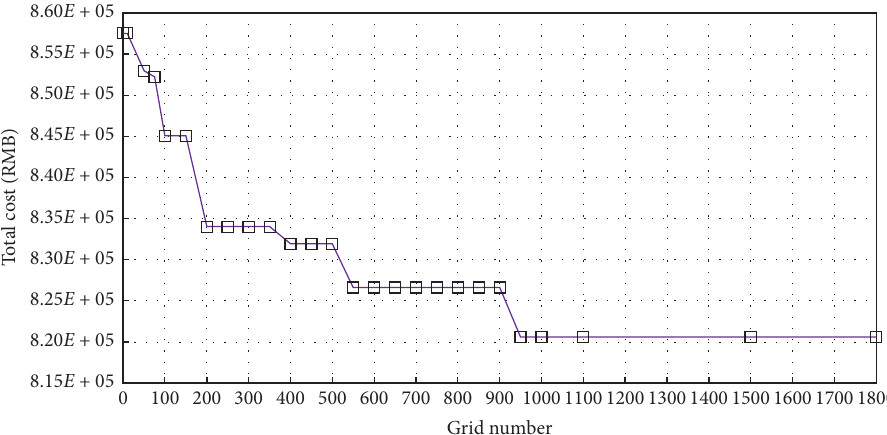
Figure 9: Sensitivity studies on total costs based on different